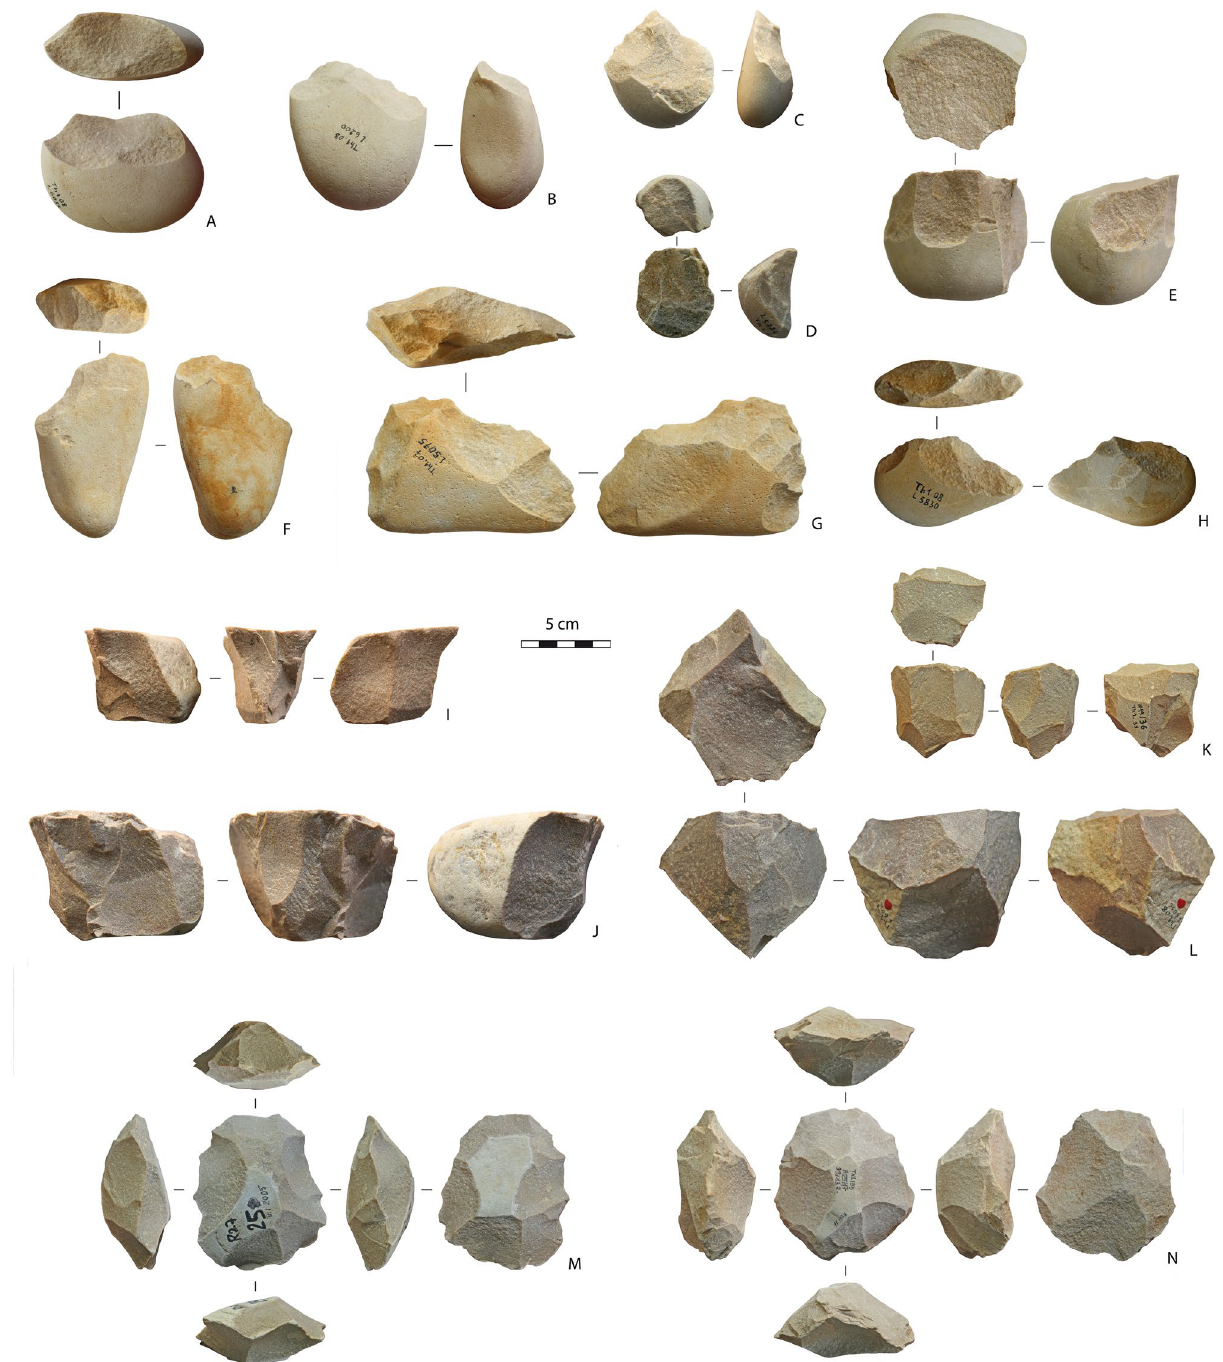
Figure 3. Quartzite cores. ( A–E ) unifacial unidirectional cores; ( F–H ) bifacial partial cores; ( I,J ) peripheral unidirectional cores; ( K,L ) multifacial multidirectional cores; ( M,N ) discoid cores. This figure was generated on the basis of photos made by R. Gallotti with Adobe Photoshop CC version 2015-1, 20151114.r301 X64. Copyright 1990 2015 Adobe Systems Incorporated and its licensors. All rights